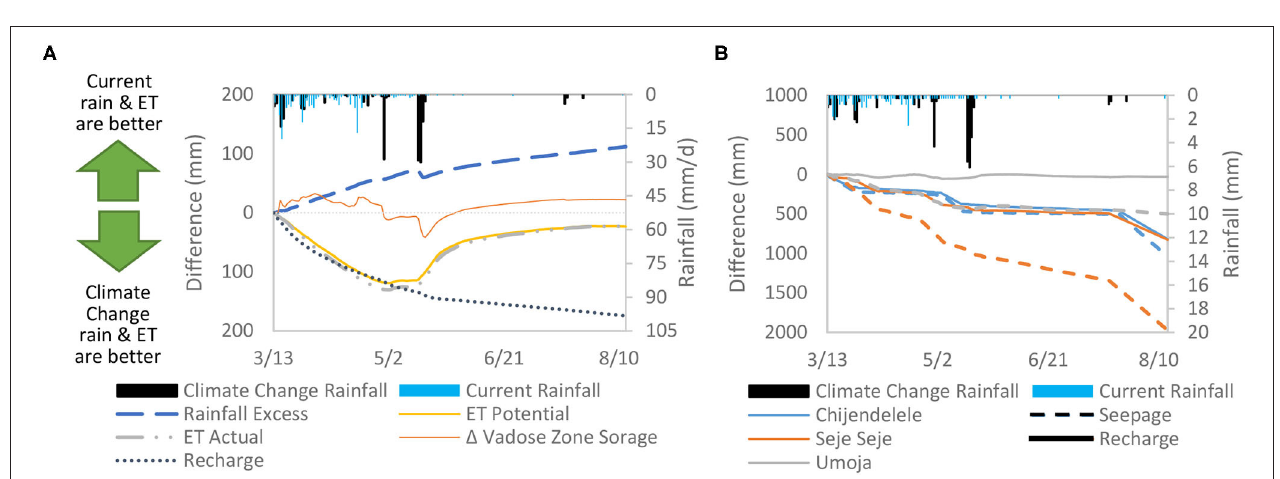
FIGURE 11 | (A) Comparative trends in aggregate overland flow quantities for the Chididimo watershed when using predicted rainfall and ET for the year 2100. (B) Comparative trends in groundwater flow parameters for each of the three sand dams after using year 2100 predicted rainfall and ET. For both (A,B) , a quantity above the y = 0 line indicates that S1 (year 2017) produced values more beneficial to water storage in sand dams than S5 (year 2100). The converse also applies with quantities below the y = 0 line indicating S5 is more beneficial. where the rain will fall on dry soil, because many weeks will supporting a relatively uniform soil moisture content. However, with climate change, rainfall events will occur infrequently but be very high intensity (World Bank, 2013). The creates a situation